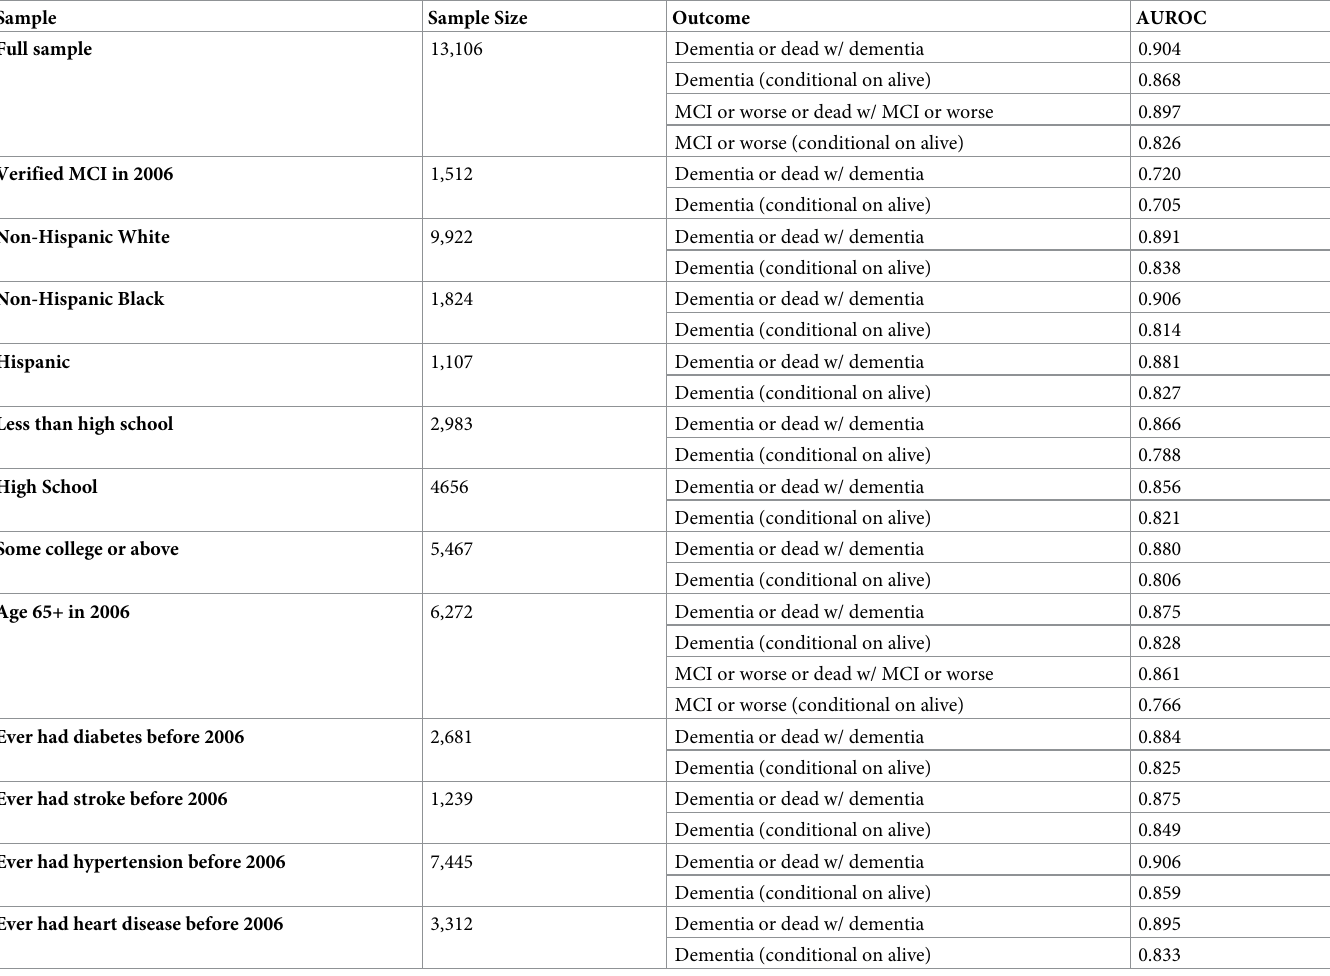
Table 5. Area under the receiver operating characteristics curve (AUROC) for predicting dementia from 5-fold